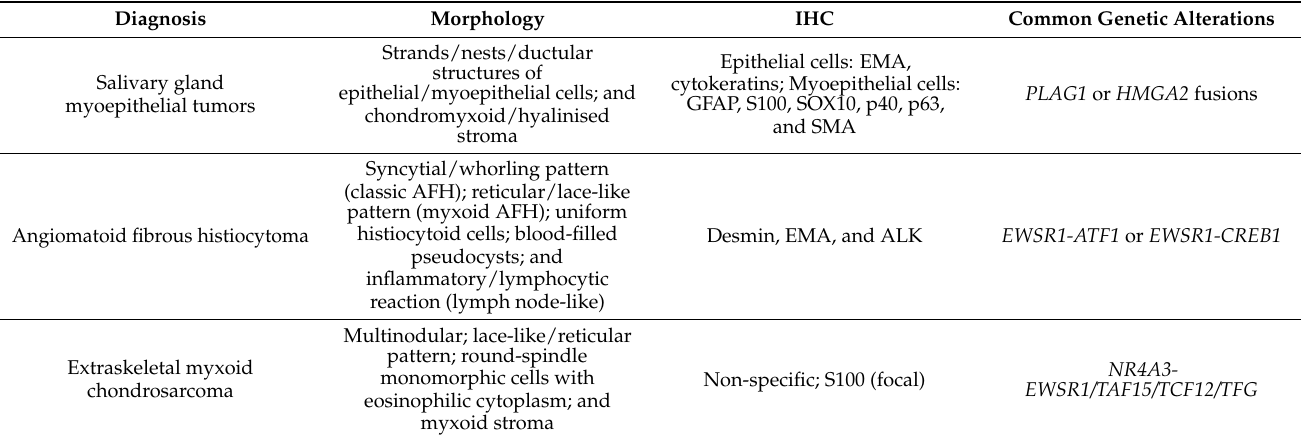
Table 6. Differential diagnoses of